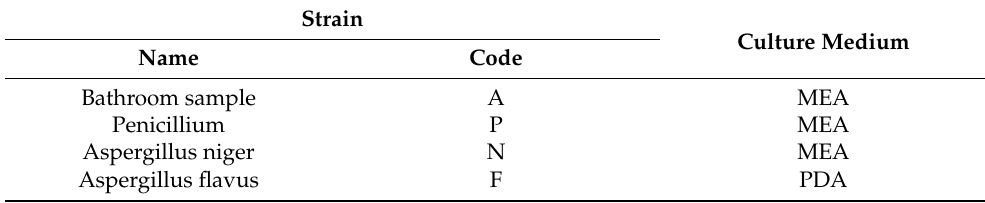
Figure 4. Pictures of inhibition zone test process: ( a ) metal rings placed on culture medium; ( b ) pi- pette extracts 0.15 mL test solution; ( c ) NO.1~NO.4 test solutions injected into metal rings, respec- tively; ( d ) metal rings carefully removed 30 min later and signs placed. Table 1. Experimental design and configuration. Table 1. Experimental design and configuration.